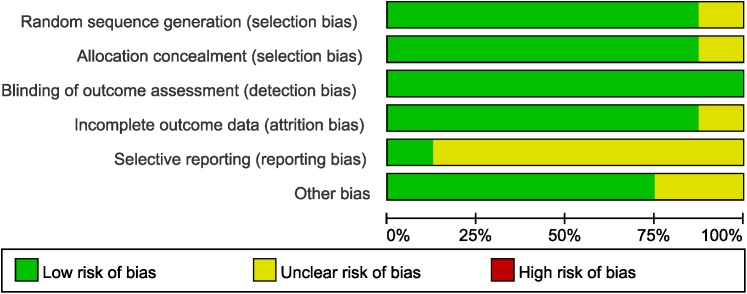
Risk of bias graph for all studies included.